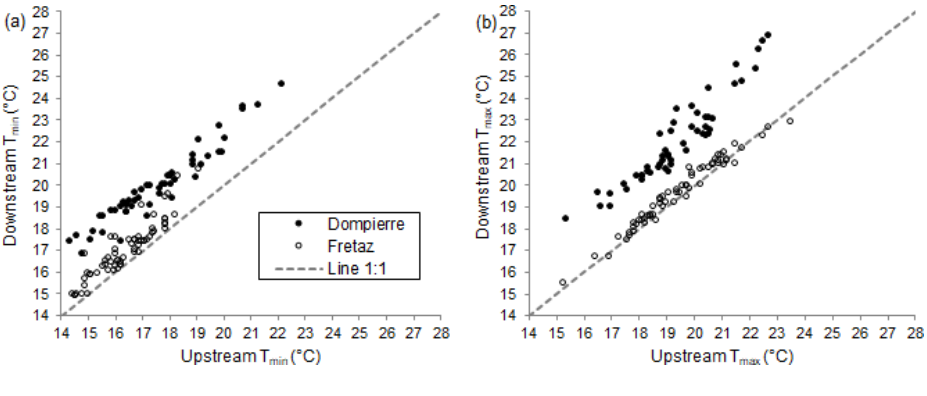
Figure 4. (a) Minimum and (b) maximum daily temperatures upstream and downstream of the run-of-the-river dams (Dompierre site, Veyle stream in 2010; Fretaz site, Veyle stream in 2014). The dashed line is the 1 : 1